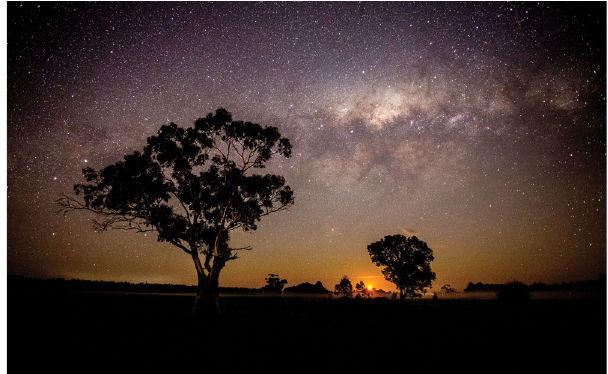
FIG. 3. Image of the night sky showing the Milky Way galaxy. Image credit: Saeed